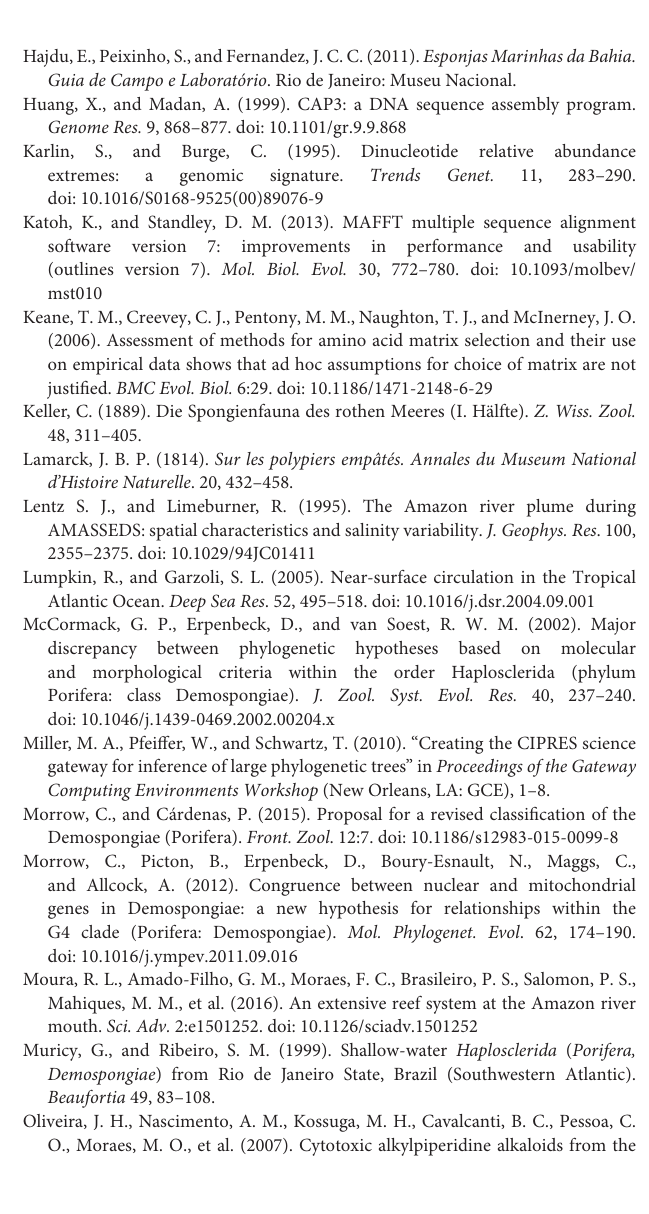
Figure S1 | (A) Amphimedon compressa Duchasssaing and Michelotti, 1864 (MNRJ 18771) and (B) Callyspongia vaginalis Lamarck, 1814 (MNRJ 18812) used to obtain HiSeq (Illumina, USA)